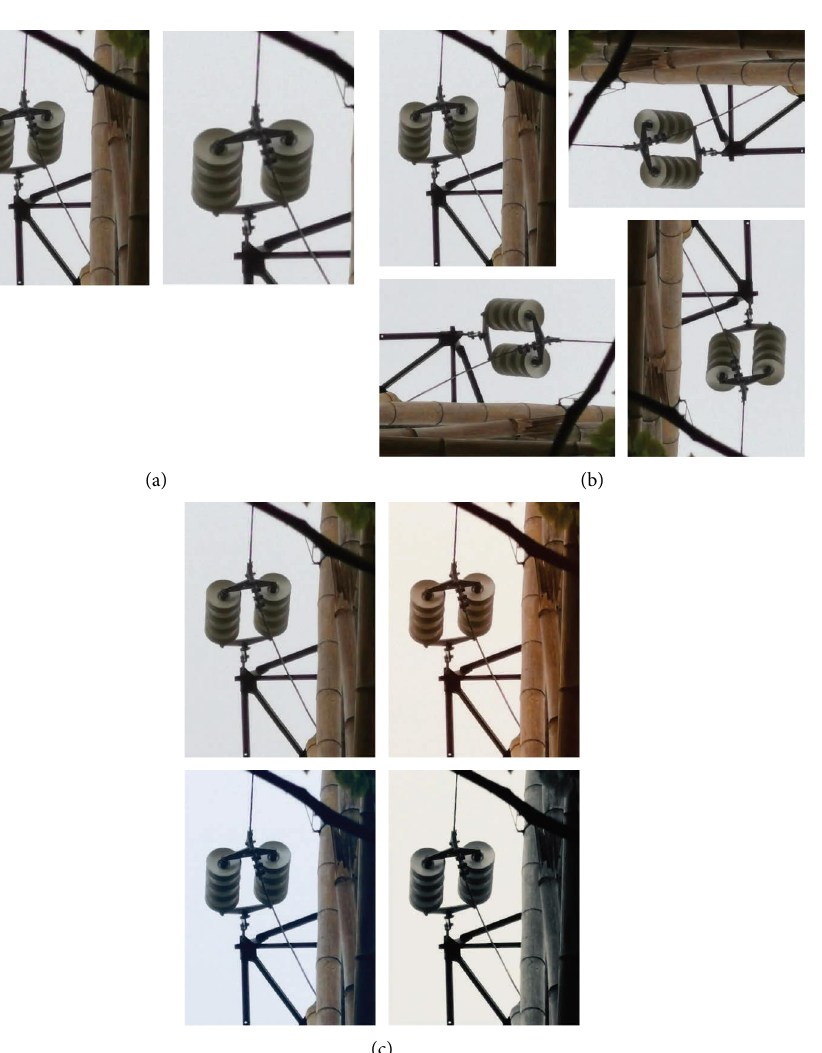
Figure 6: Transmission line image preprocessing. (a) Auto clipping. (b) Image rotation. (c) HSV